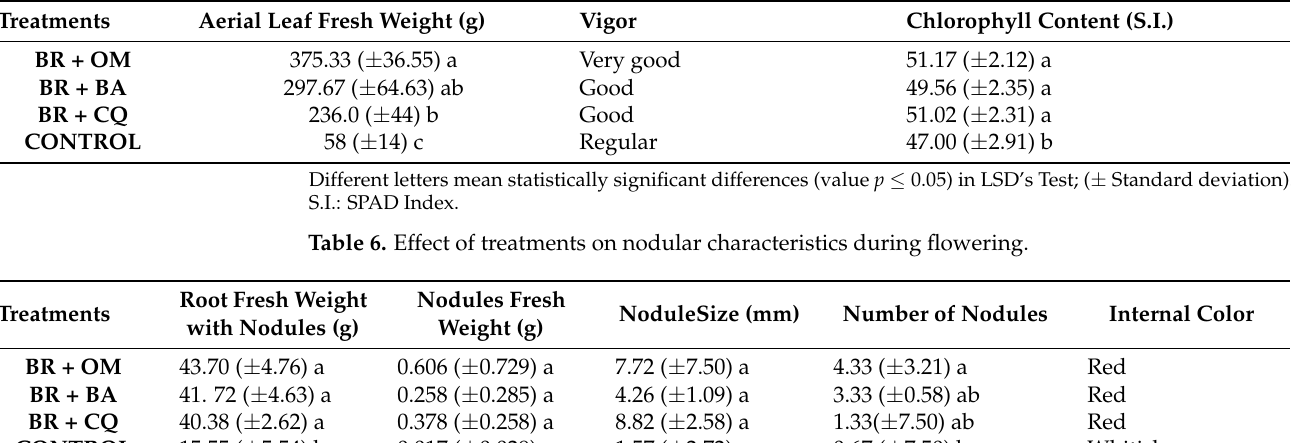
Table 5. Effect of treatments on foliar characteristics during flowering.